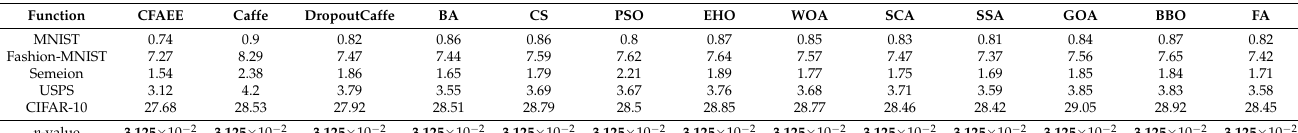
Table 19. Statistical comparison of classification error rate metrics obtained by CFAEE for CNN experiments, with other approaches by Wilcoxon Signed-Rank Test at α = 0.05.